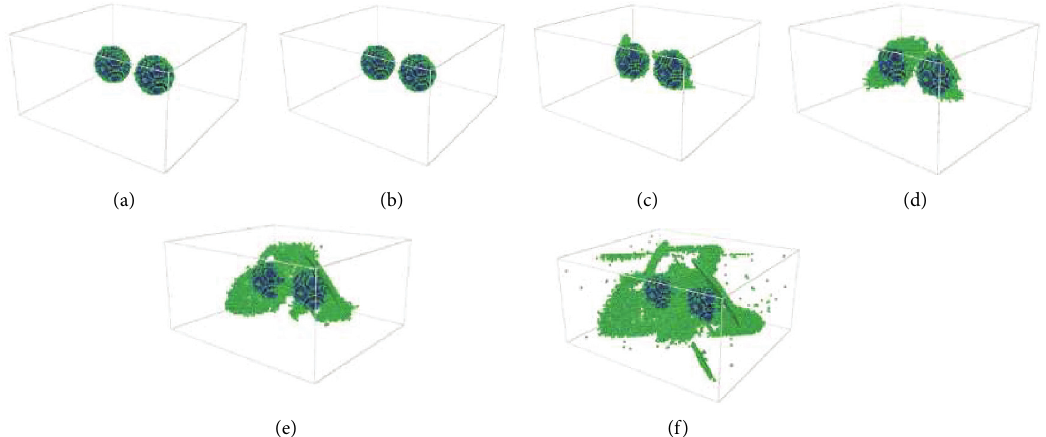
Figure 7: Dislocation emission by the void surface by CSP. (a) ε (f) ε ic � −